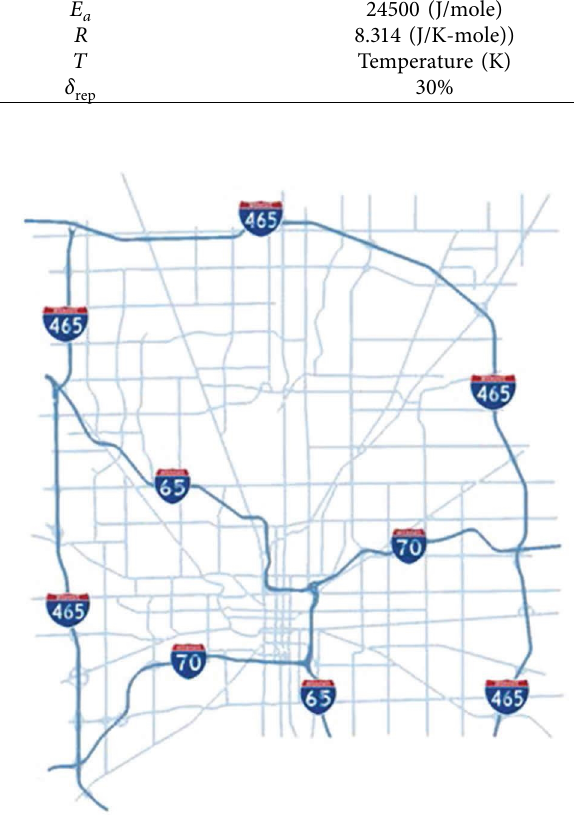
Figure 3: Road network of Indianapolis, U.S., used in the